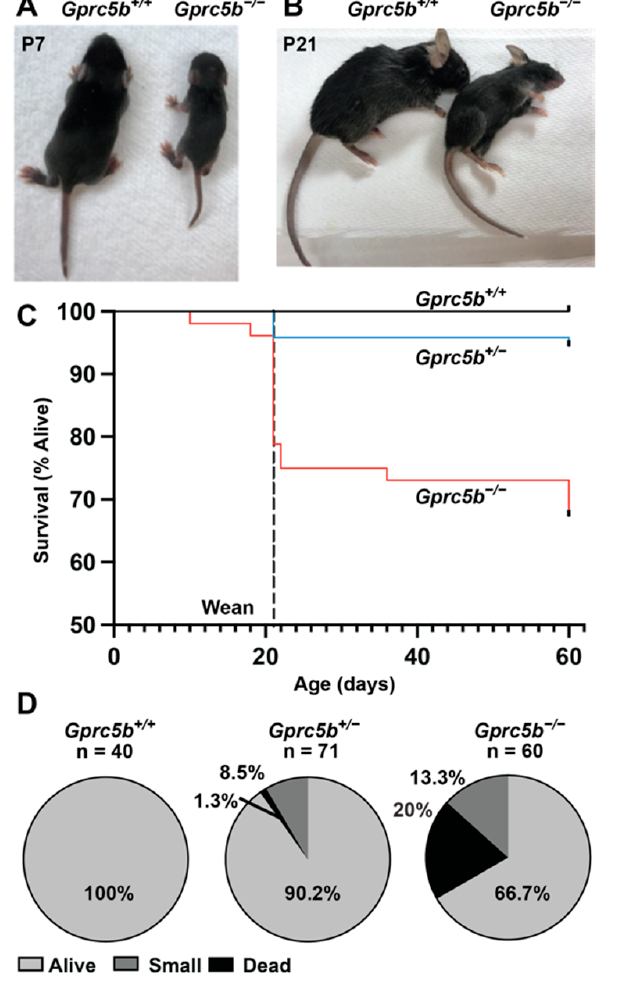
Figure 5. Gprc5b − / − mice die postnatally and exhibit growth restriction. ( A,B ) Representative images of Gprc5b +/+ (left) and Gprc5b − / − (right) mice at postnatal days 7 (A) and 21 (B), showing marked growth restriction in Gprc5b − / − mice. ( C ) Survival curve shows ~25% loss of Gprc5b − / − mice prior to weaning. ( D ) Quantitation of growth restriction and death phenotypes by genotype from heterozygous Gprc5b +/ − intercrosses.